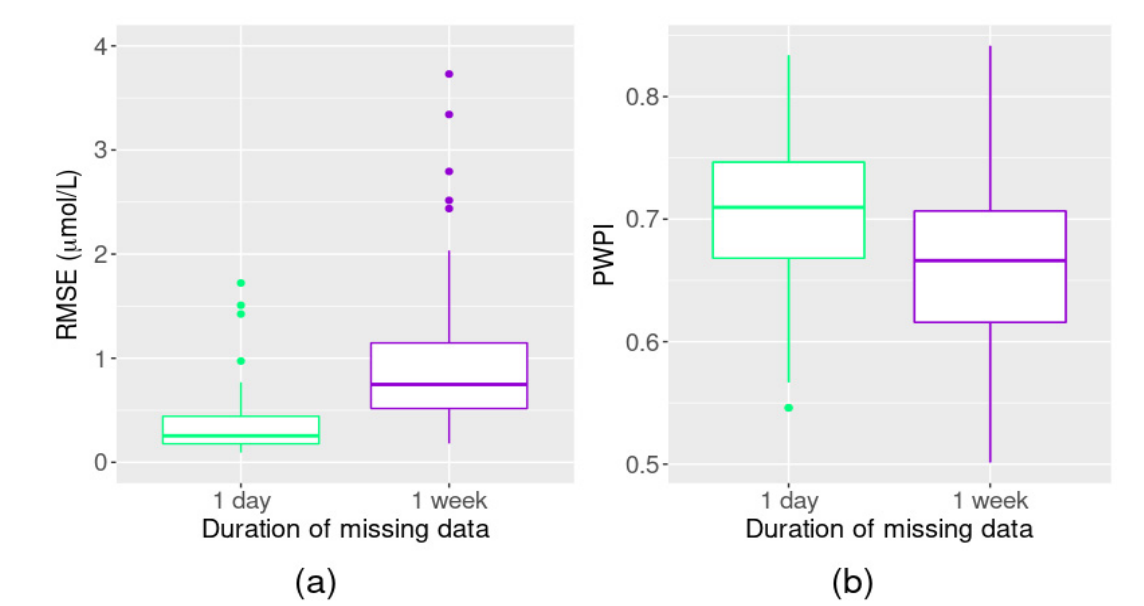
Figure 6. Performance evaluation: reconstructing sequences of missing data. Boxplots of ( a ) root-mean-square error (RMSE) and ( b ) the proportion of reconstructed data within the precision interval (PWPI) for different amounts of randomly removed point observations, simulated 100 times. Note that the y -axis on plot ( a ) has been truncated at 4 µmol/L (one extreme RMSE value of 45.23 µmol/L for the one-week simulations not shown).